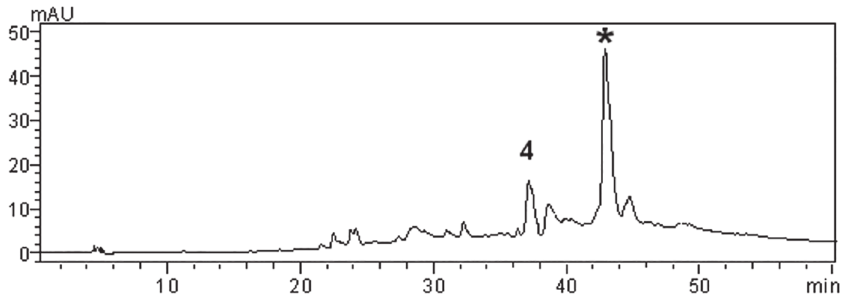
Figure 3 - HPLC analysis of rutin (4) of the EtAc fraction of the fruits, (*) unknown